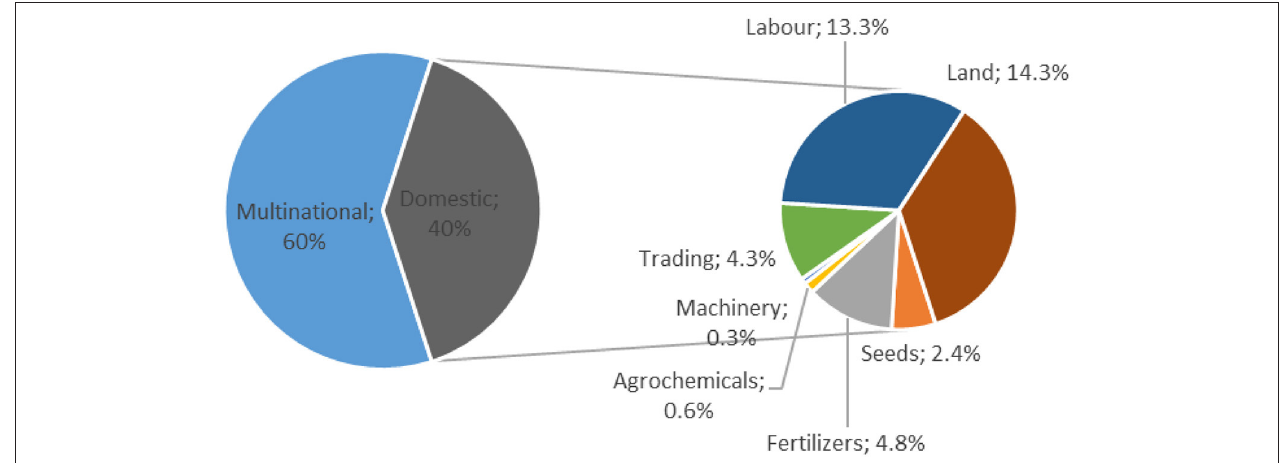
FIGURE 1 | Share of Brazilian capital in the production chain of soybeans produced in Brazil (in %). Source: This